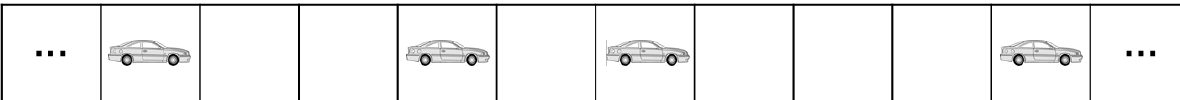
Figure 1. The discrete cellular automata (CA) model with defining road sections as cellular.